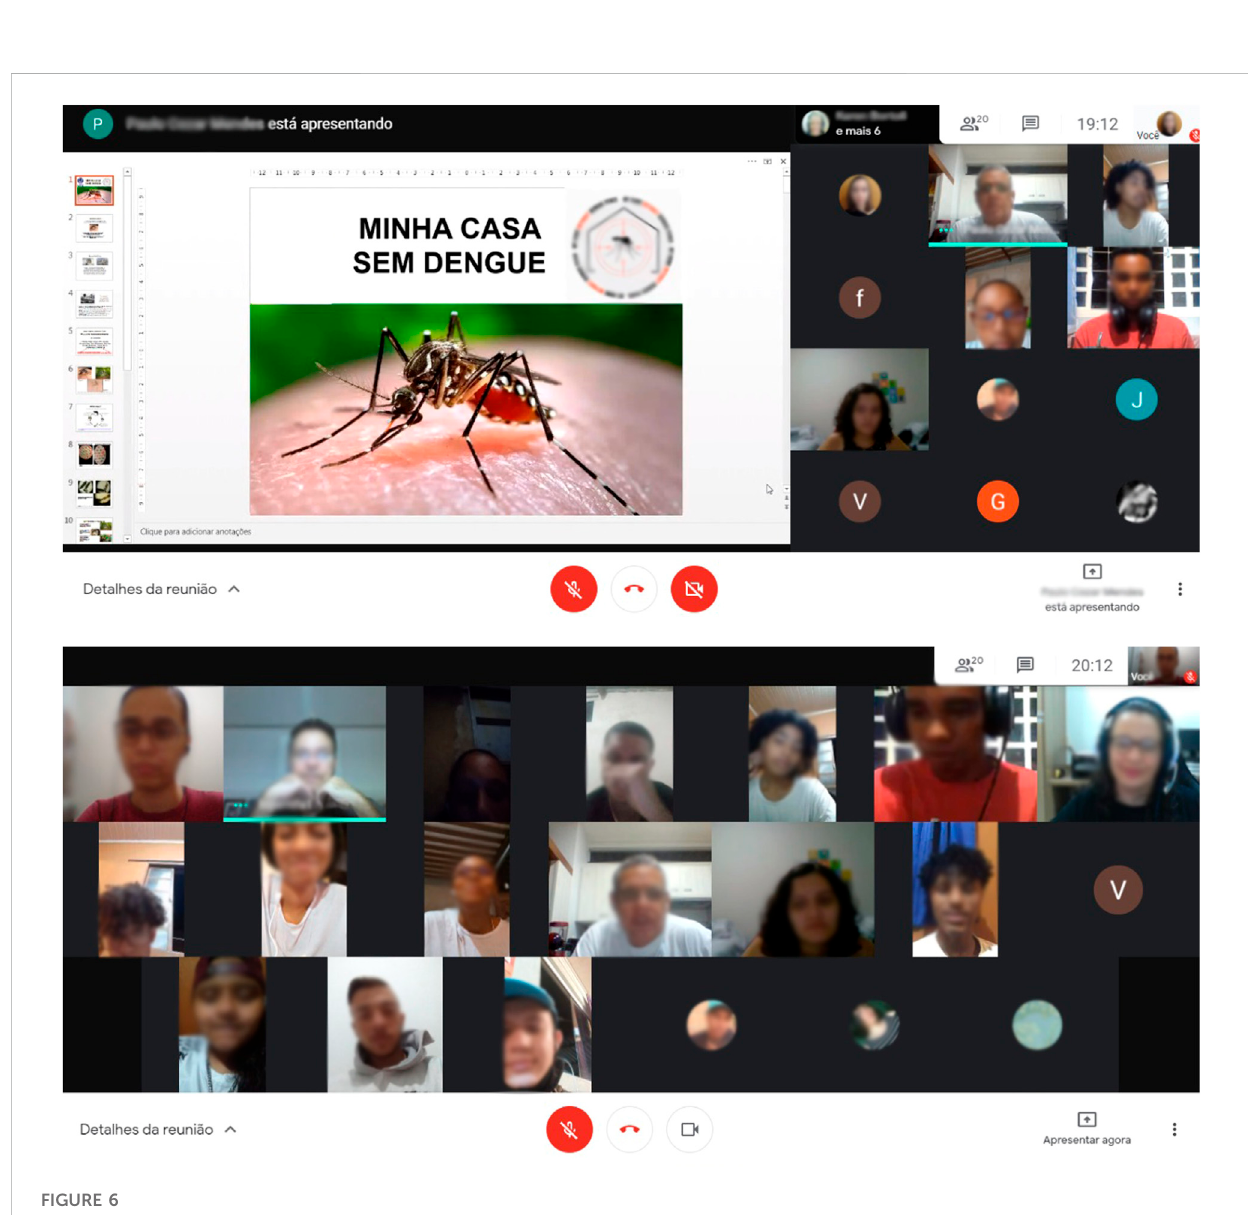
FIGURE 6 Workshop 1B with students ’ screen